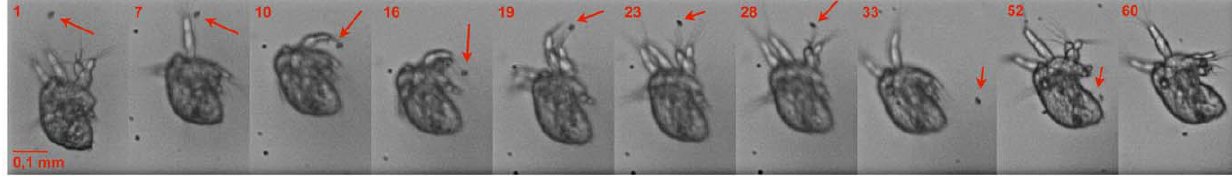
Figure 4. Prey capture in Acartiatonsa . Time series of still images with frame numbers indicated (consecutive frames are 0.5 ms apart). Arrows point towards the prey. In the last image the prey has been captured.